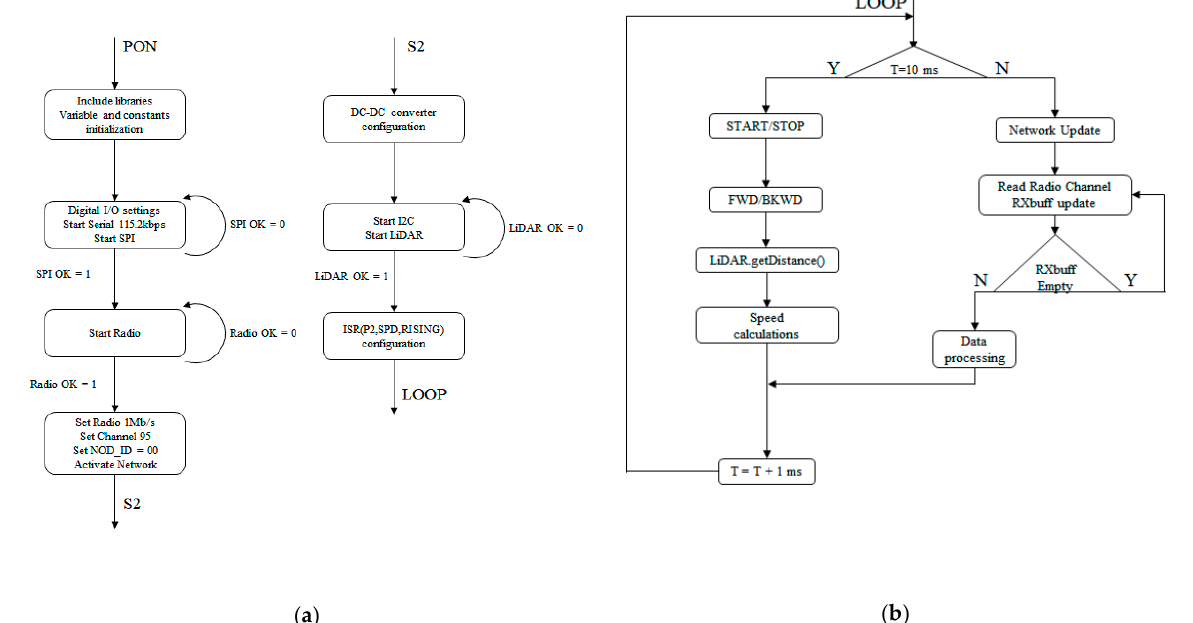
Figure 12. SETUP state ( a ) and LOOP state ( b ) diagrams for the SLAVE#1 and SLAVE#2 software.